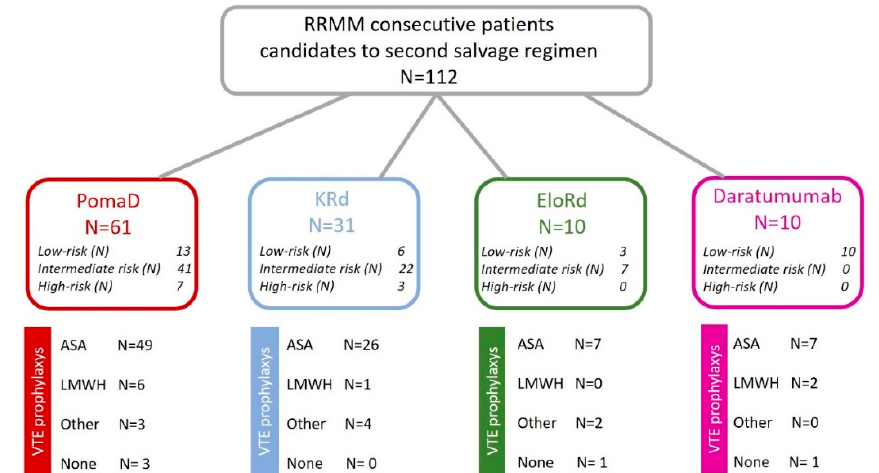
Figure 1. Regimens used as third-line of treatment in RRMM patients evaluated in this single-center retrospective study. The IMPEDE score was applied to distinguish patients in low, intermediate and high risk of VTE. For each treatment group, the VTE prophylaxis choice has been reported.